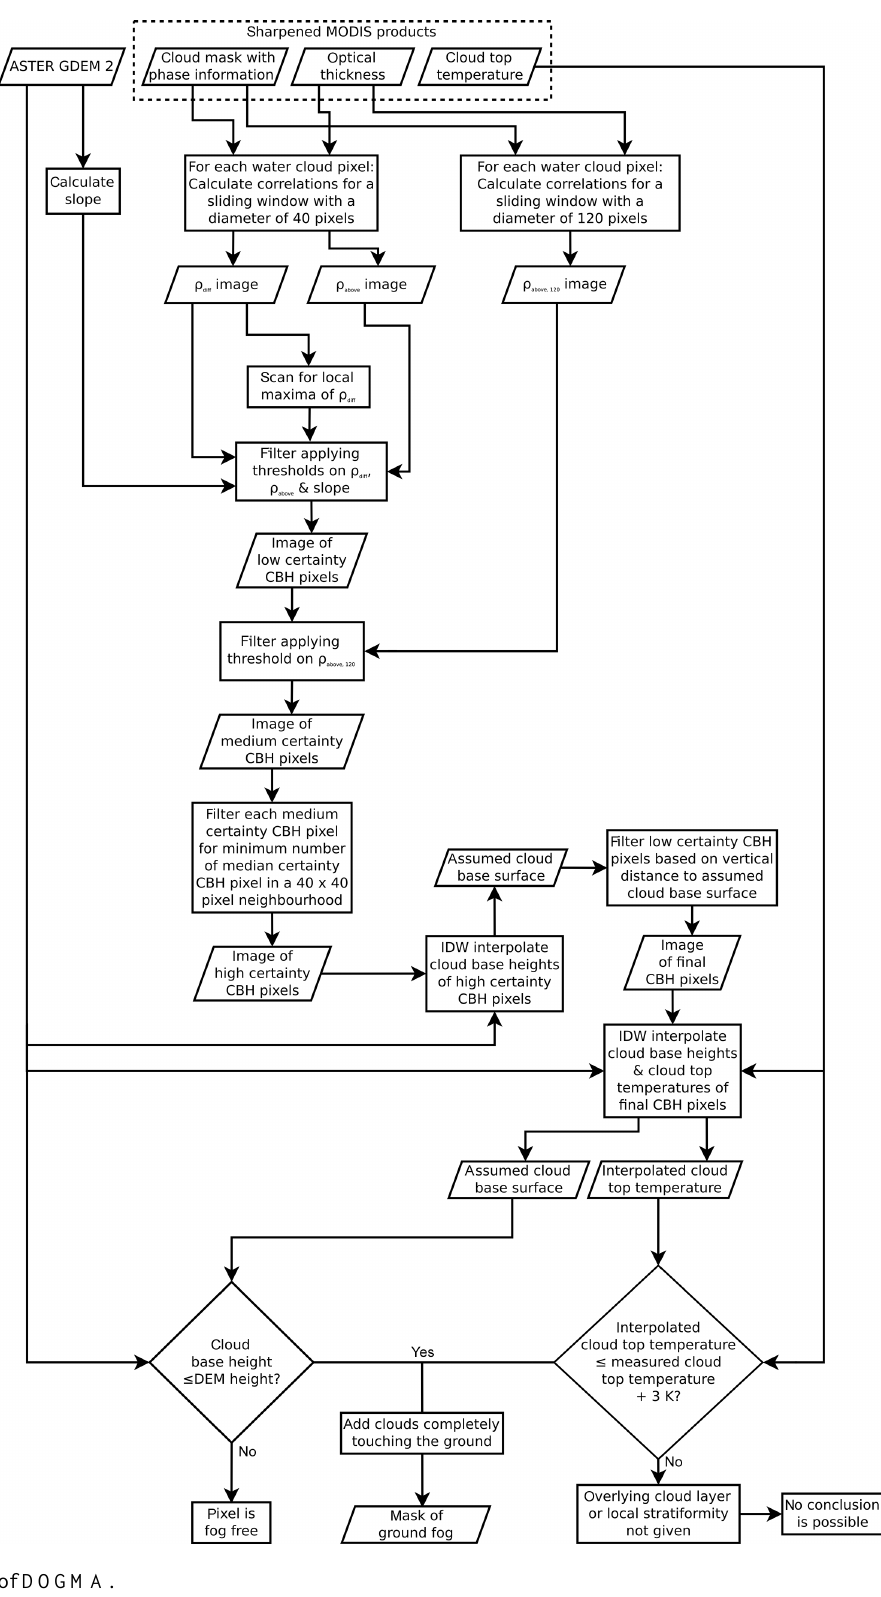
Figure 9. Overview of